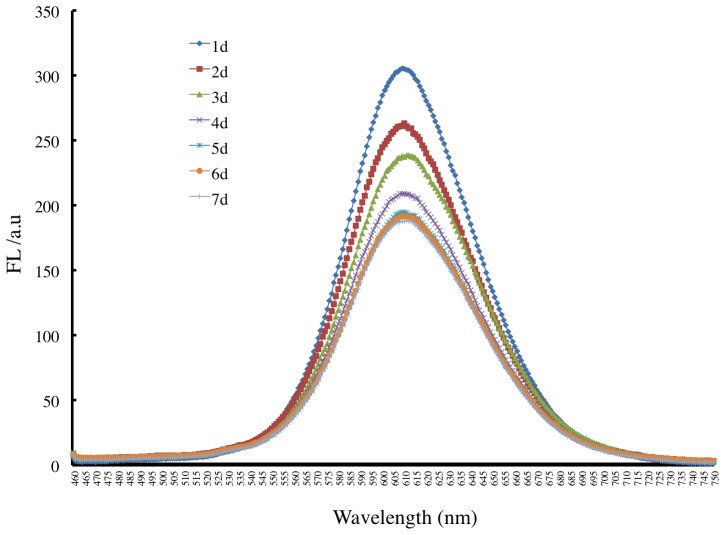
Time course of full wavelength scanning of TGA-capped CdTe QDs.